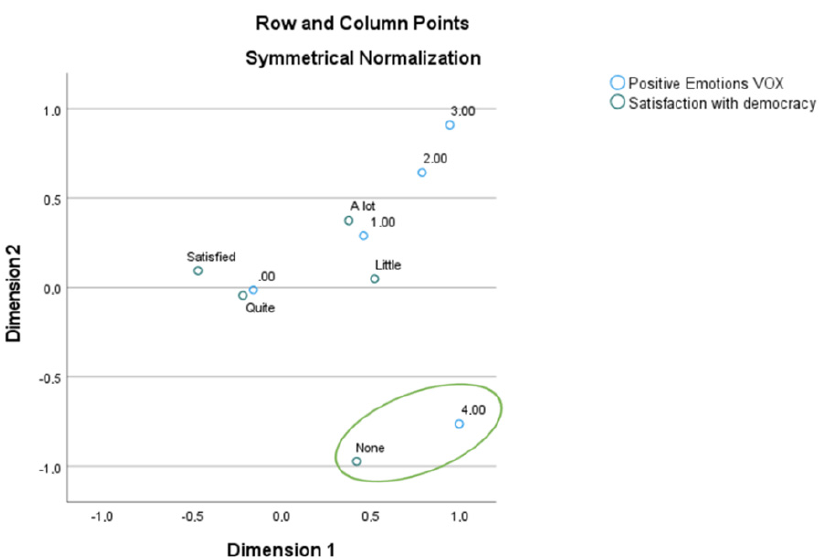
Figure 3. Correspondence analysis of the level of satisfaction with democracy in relation to positive emotions towards VOX. Source: authors’ own creation based on the data of the post-electoral study of the November 2019 general election conducted by Political Research Team.